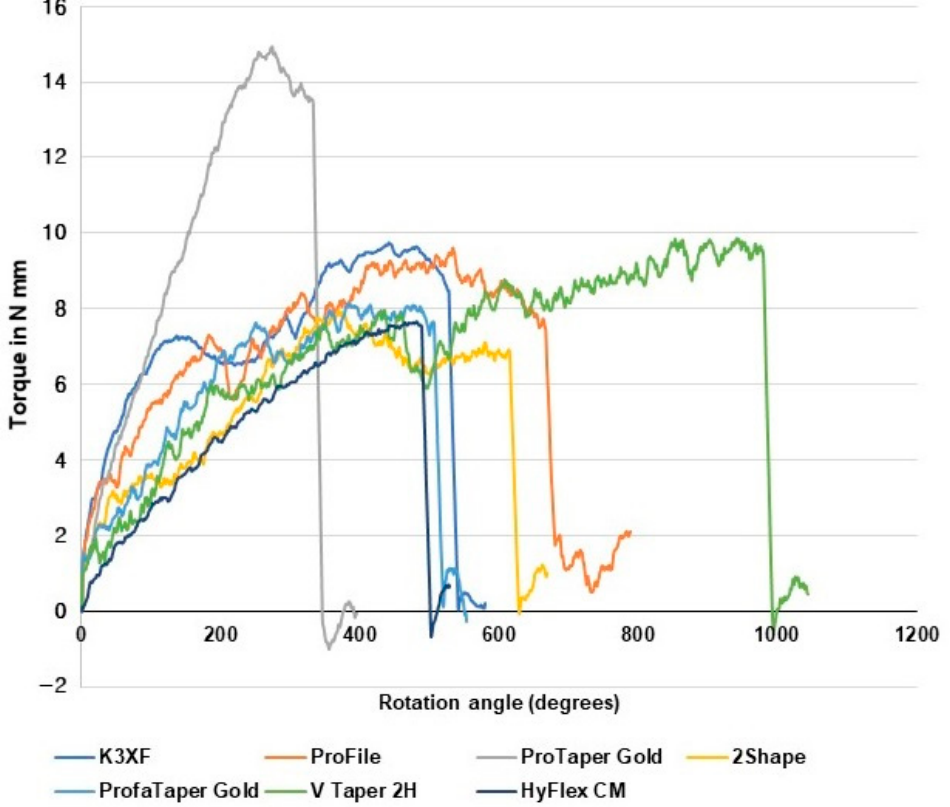
Figure 3. Torque vs. rotational angle plots showing the point of torsional fracture for each NiTi file. The slope of the initial linear portion of the graph was obtained as the stiffness.